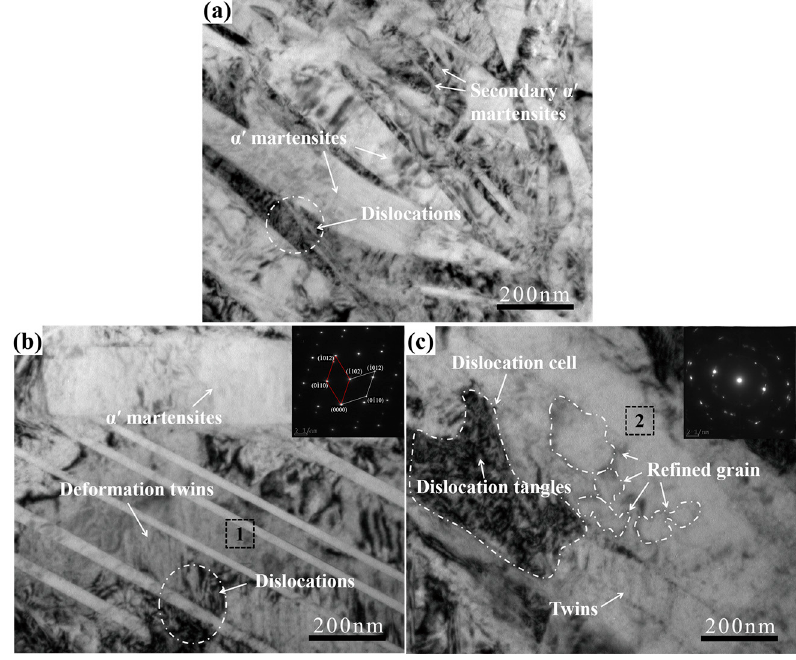
Figure 4. TEM images of top surface before ( a ) and after 1000 N 6 passes of USRP ( b , c ).